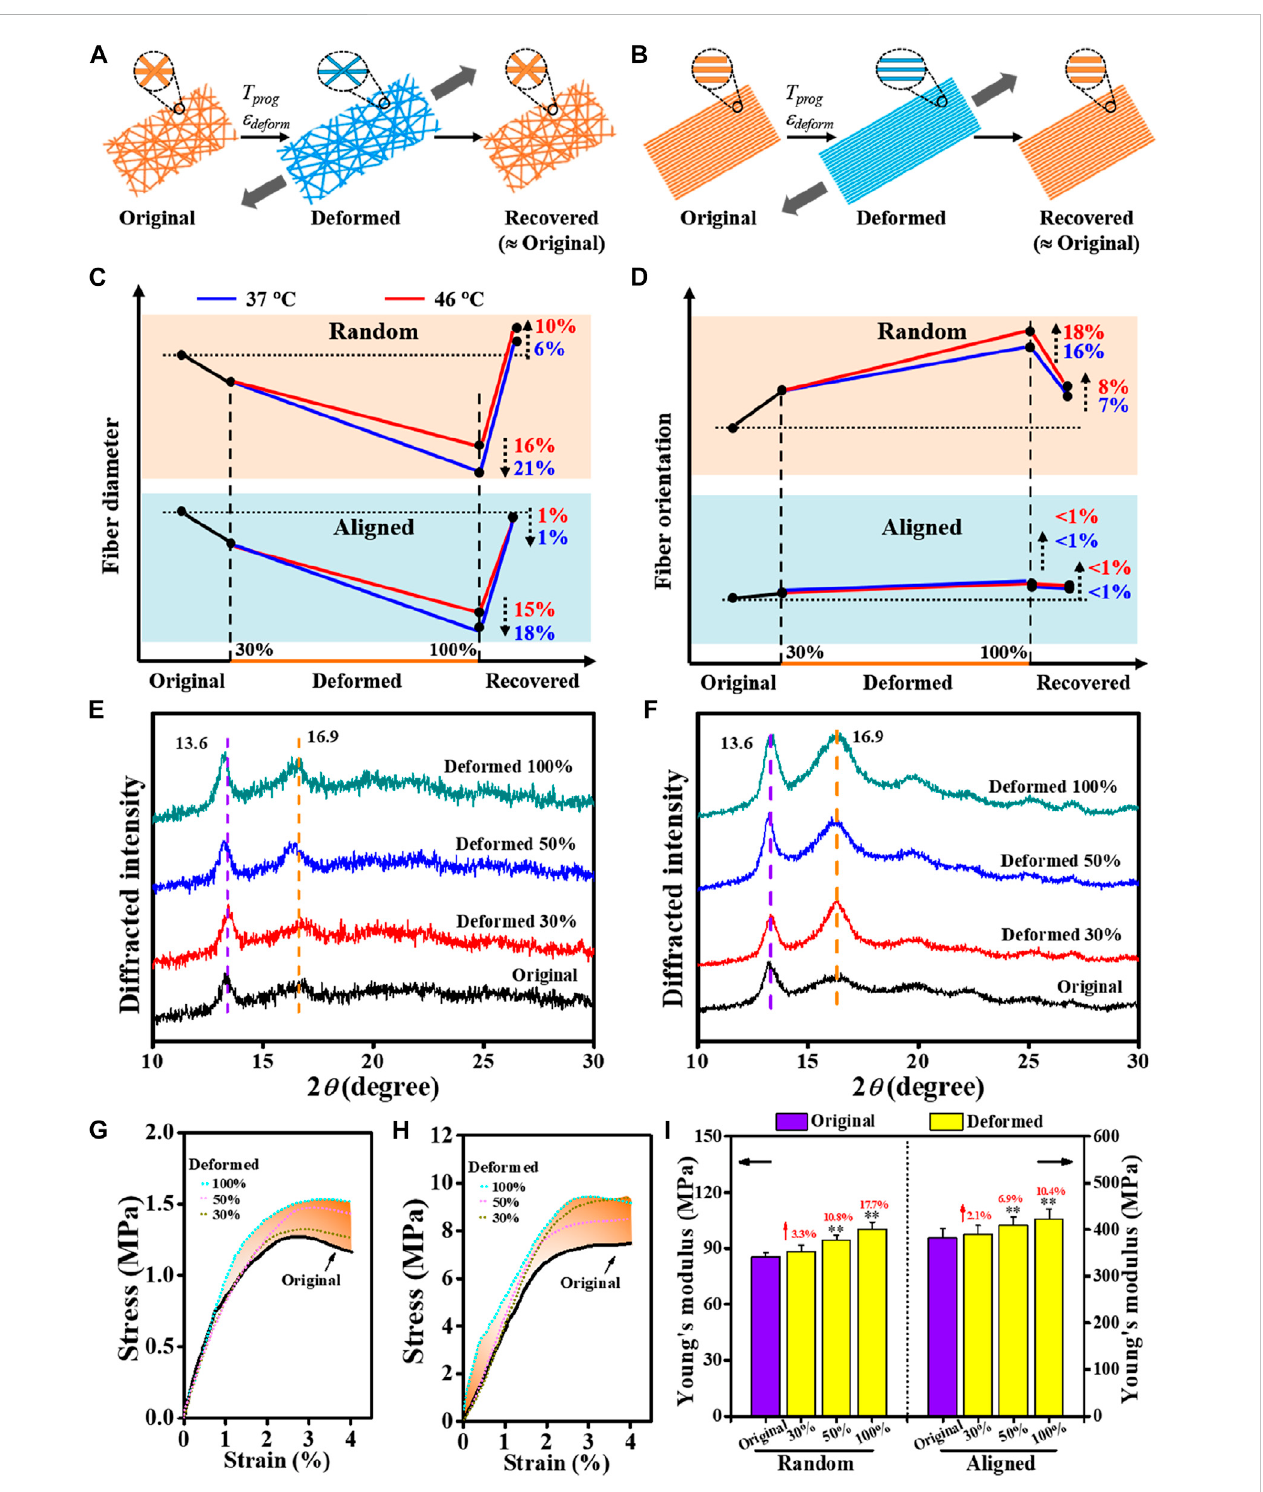
FIGURE 3 Comparative study on morphology changes regulated by shape-programming parameters between random and aligned fi bers. (A, B) Schematics of morphology changesin acomplete shape memorycycle. (C,D) Dynamic changesin fi ber diameter and fi ber orientation regulatedby shape-programming. (E, F) XRD patterns due to applying ε deform varied in 30%, 50%, and 100% at T prog of 37 ° C (E) for random and (F) for aligned). (G, H) Representative tensile stress − strain curves of original and deformed (G for random and H for aligned). (I) Young ’ s moduli derived from (G) and (H)